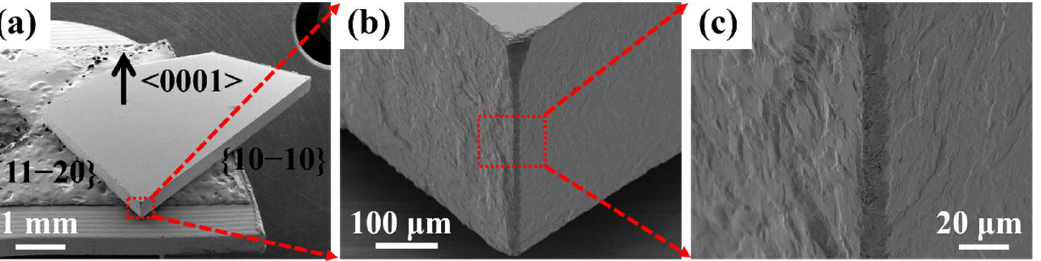
Figure 4. SEM images of the kerfs after ultrafast laser PLSD of SiC wafers with the magnification of ( a ) 40 × , ( b ) 500 × and ( c ) 2000 × .